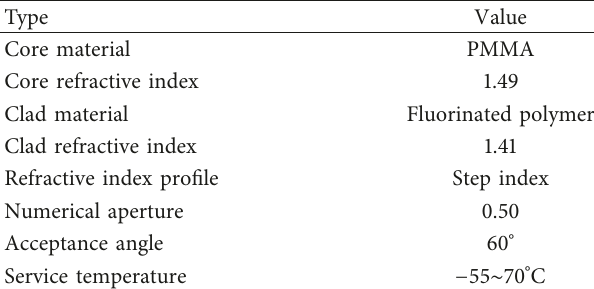
Figure 1: Possible applications of POF-based smart textile. (a) Light-delivery textile (self-sterilizing garment); (b) light-harvesting textile (images reproduced from http://www.google.com) Table 1: Overall specification of POF specimens.